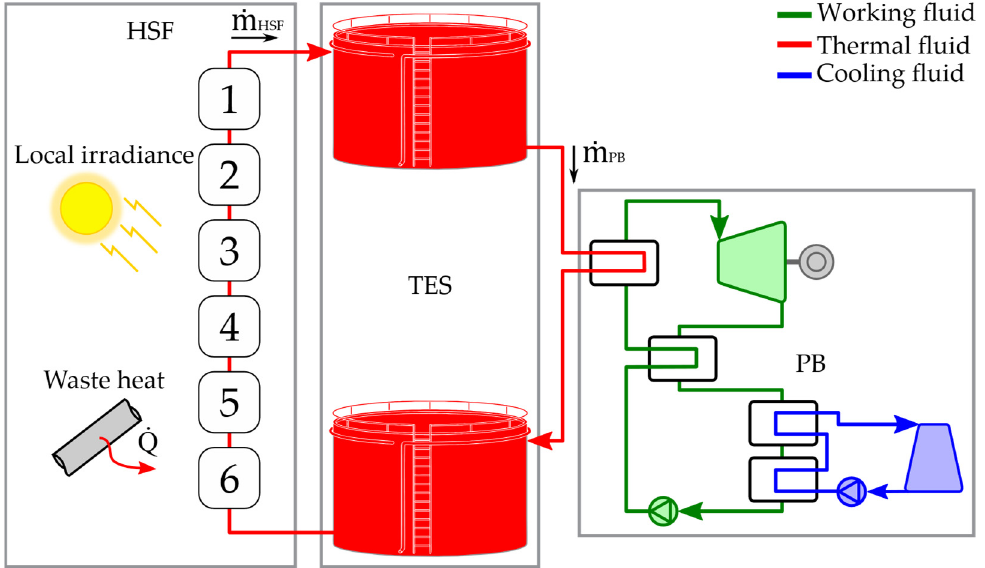
Figure 1. General hybrid solar power plant scheme with a hybrid solar field ( left ), power block ( right ) and direct thermal energy storage system ( center ).